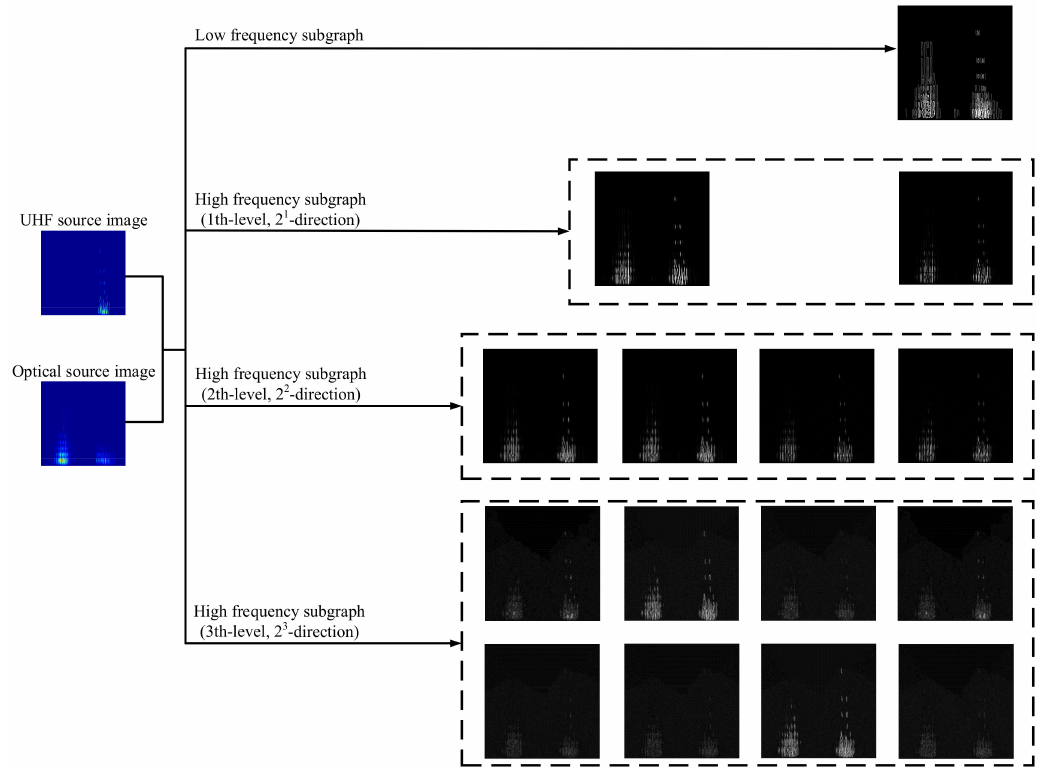
Figure 14. Fusion framework of optical and UHF patterns.